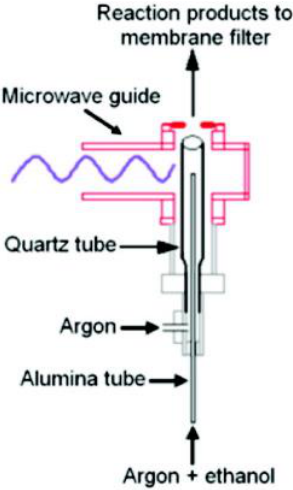
Figure 11. Schematic of a novel microwave-assisted equipment. (Reproduced from [40] with permission; Copyright 2008 American Chemical Society.)